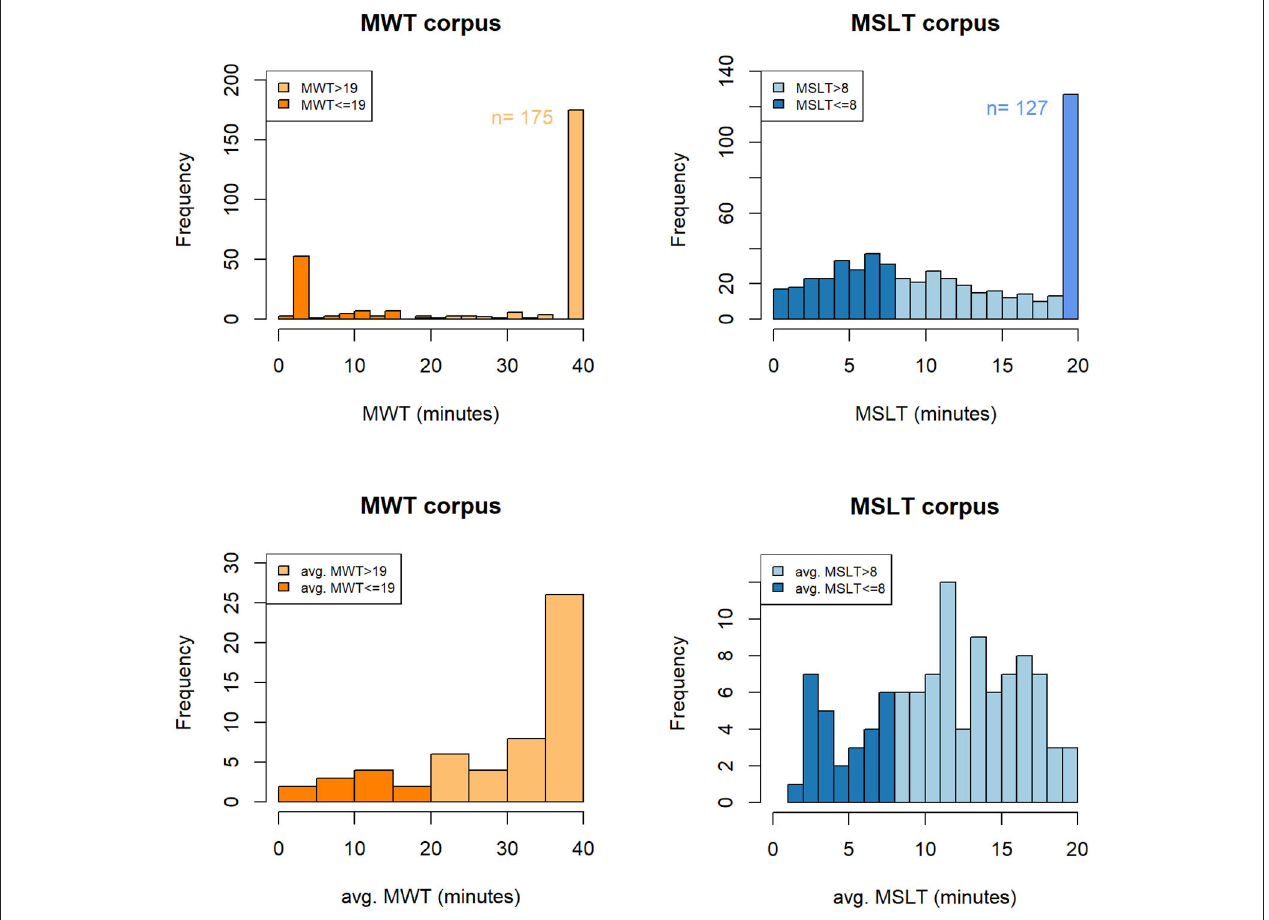
FIGURE 6 | Histogram of the objective measures of the short-term (A,B) and the long-term (C,D) sleepiness on the MWTc and MSLTc. MWT, sleep latency to the Maintenance of Wakefulness Test; MSLT, sleep latency to the Multiple Sleep Latency Test; avg. MWT, average sleep latency across the four sessions of the Maintenance of Wakefulness Test; avg. MSLT, average sleep latency across the five naps of the Multiple Sleep Latency Test; n, number of samples corresponding to saturation. a subjective way the same phenomena as MSLT (high